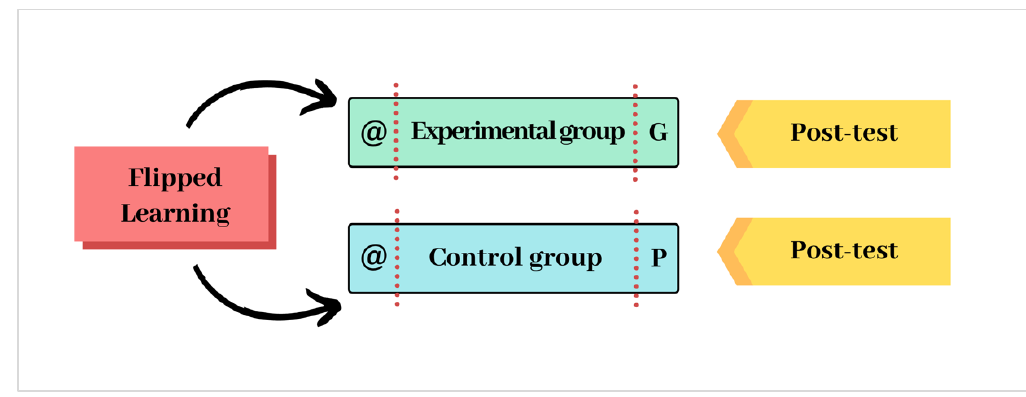
Figure 1. Methodological procedure. Note. @ = Digital learning phase; P = Face-to-face learning phase; G = Gamified activities.